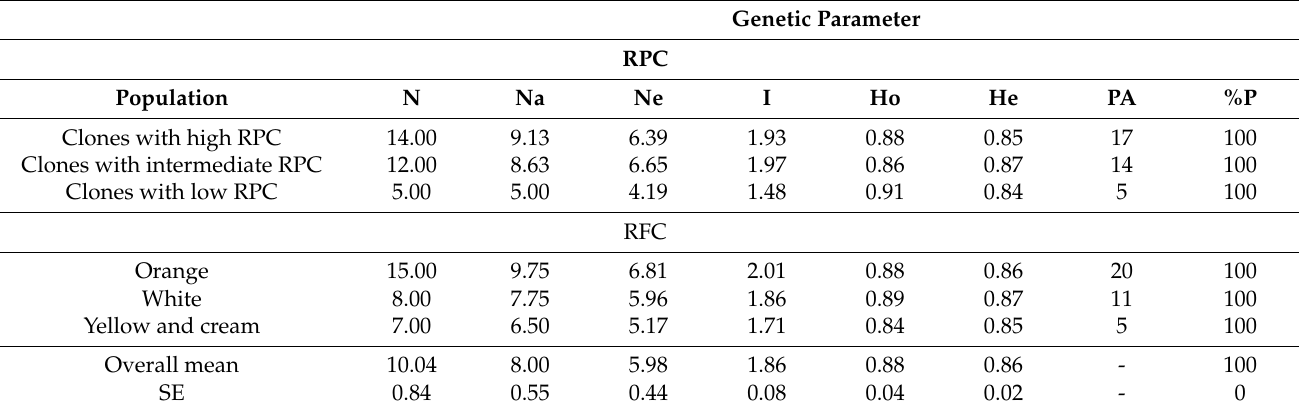
Table 4. Genetic diversity within and among the 31 sweetpotato genotypes classified by root protein content and flesh